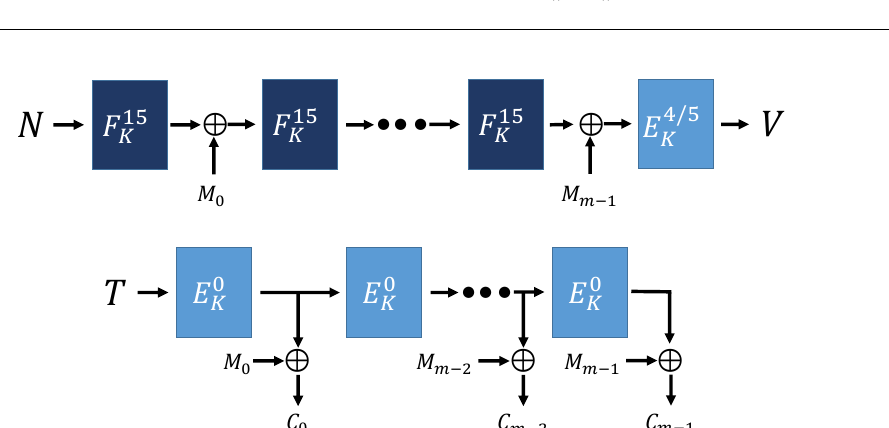
Figure 10. sESTATE mode (no AD, using Message) [16].